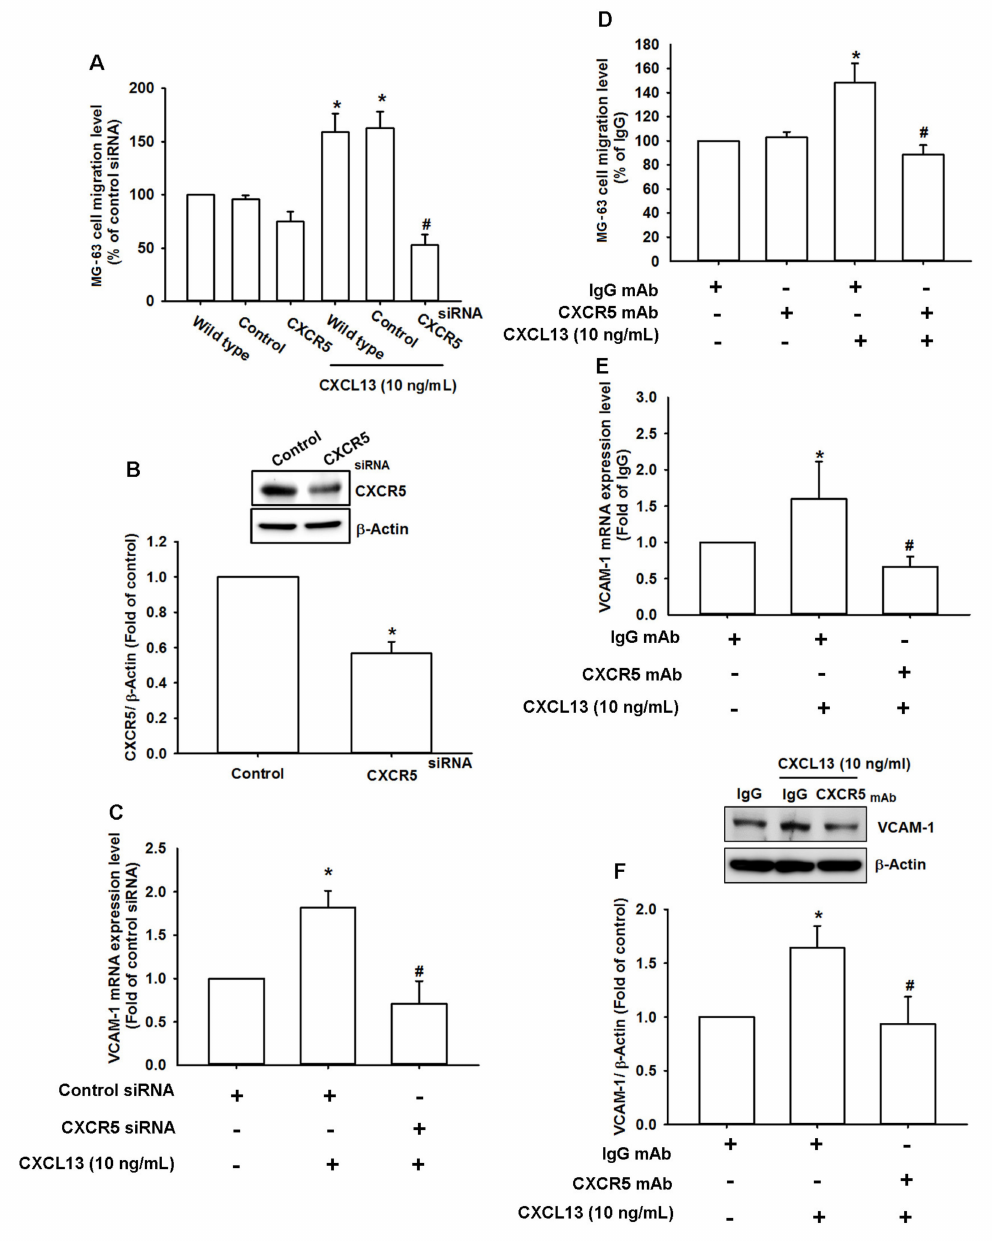
Figure 3. The CXCL13 / CXCR5 axis increases VCAM-1 expression and cell migration. MG-63 cells were transfected with CXCR5 siRNA ( A – C ) or pretreated with CXCR5 antibody ( D , E ), then stimulated with CXCL13; migratory potential and VCAM-1 expression was examined by Transwell, qPCR and Western blot assays. ( F ) MG-63 cells were pretreated with CXCR5 antibody then stimulated with CXCL13; VCAM-1 protein expression was examined by Western blot assay. * p < 0.05 compared with the control group; # p < 0.05 compared with the CXCL13-treated